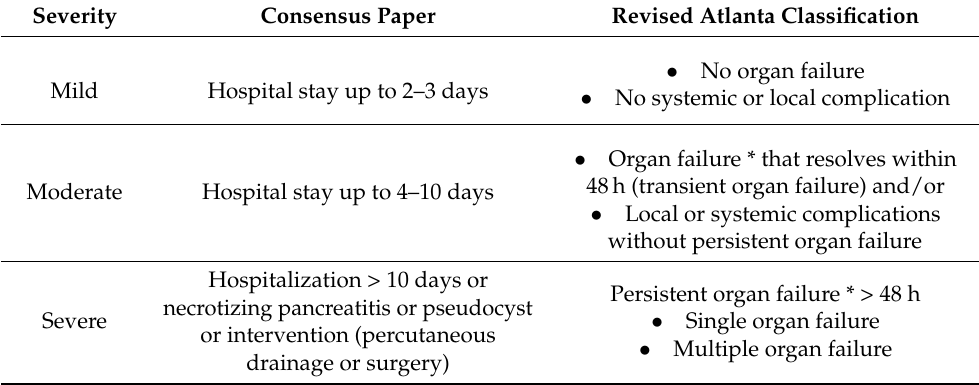
Table 1. Comparison of severity grade according to the consensus paper and the Revised Atlanta